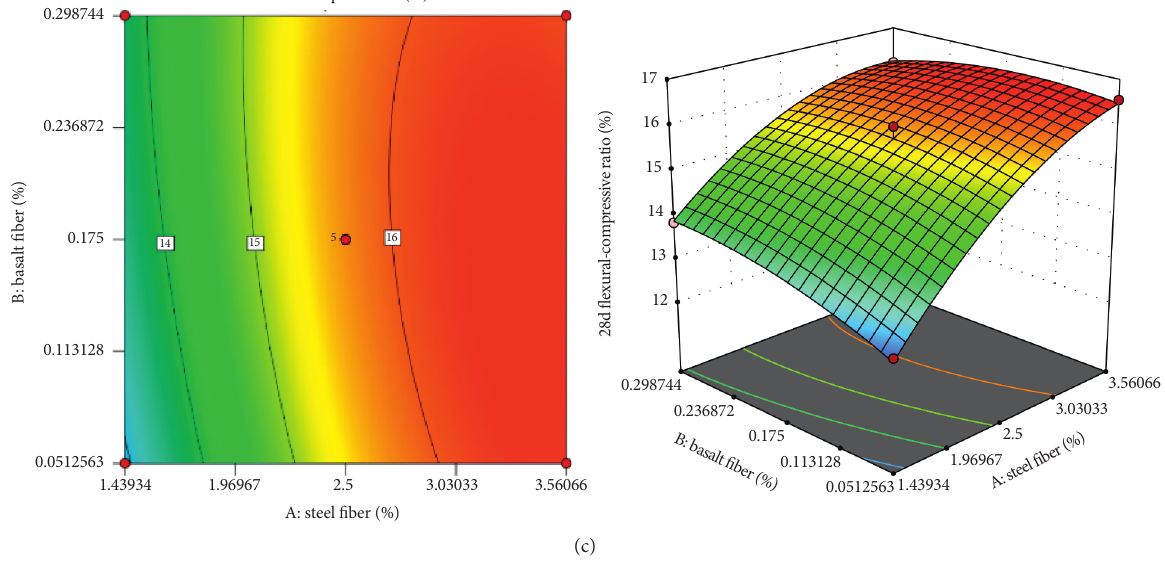
Figure 14: Contour and 3D plots: (a) R1; (b) R2; (c) R3. Table 14: Definitions of factors and responses in the multiobjective optimization process.